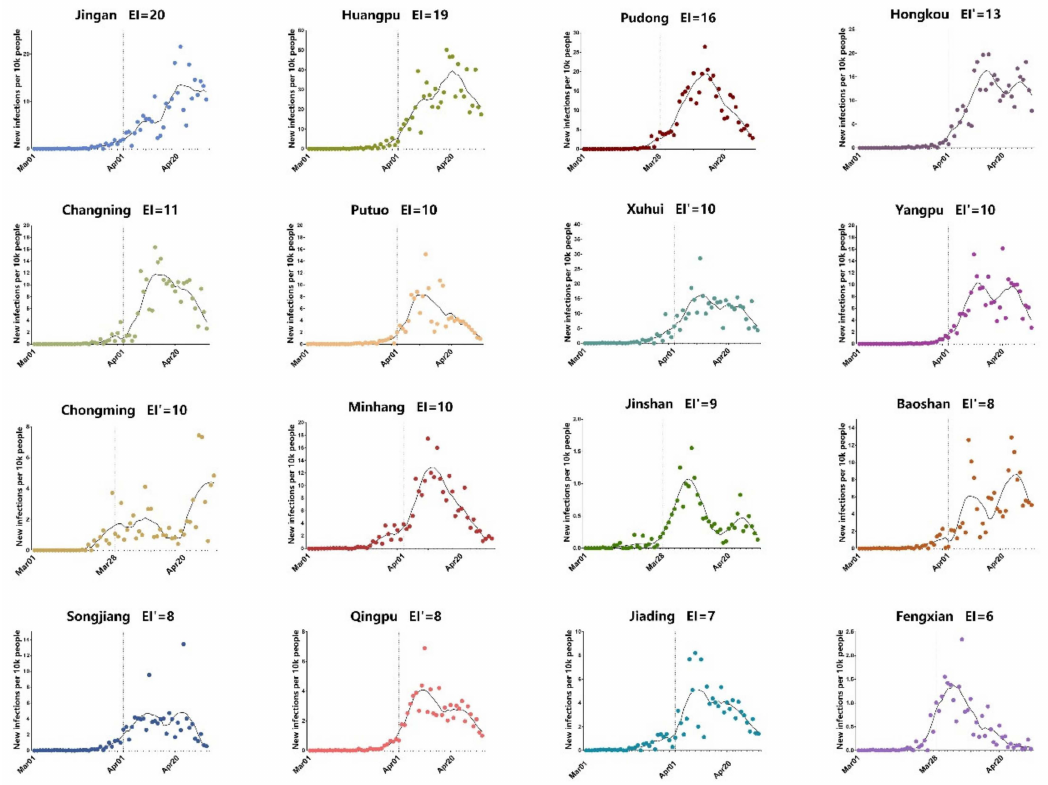
Figure 3. Daily new infections in 16 districts of Shanghai. The daily new infections from 1 March 2022 to 30 April 2022 in 16 districts of Shanghai were plotted as dots. The raw data were smoothed following a 7-day averaged, 4th-order polynomial method, and the trends were plotted as black curves. Dashed vertical lines indicate the lockdown date of each district. EI, the leading time from the lockdown starting date to the daily omicron cases peaking date, was labeled for each district. For districts with double peaks, EI was identified based on the first peak and differentiated as EI’.